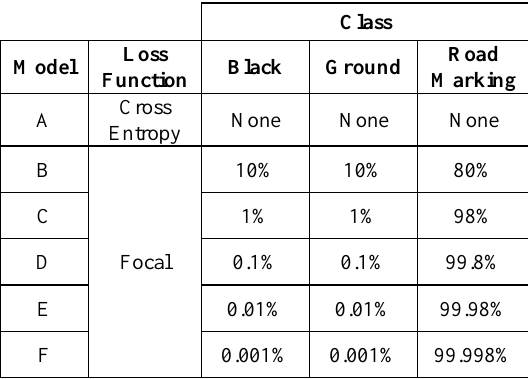
Table 1. Model Class Weights